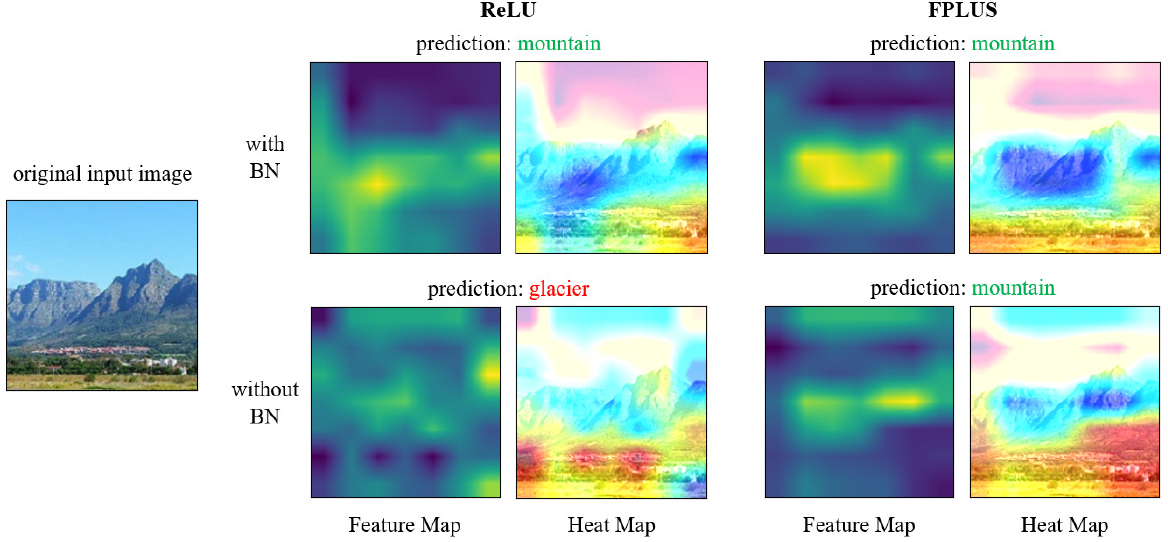
Figure 11. Visualization of feature maps and heat maps produced by model’s final convolutional layer, under two circumstances whether batch normalization is employed or not. Original input image as well as corresponding predictive results for ReLU and FPLUS are given in the figure to